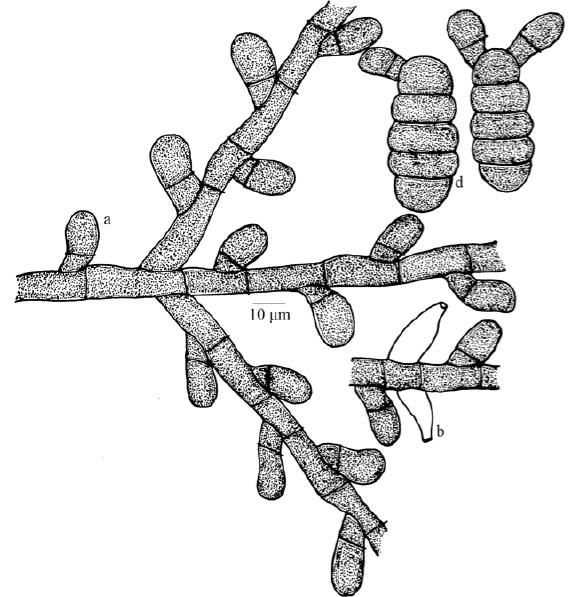
Figure 1. Amazonia flacourtiae a - Appressorium; b - Phialide; d -